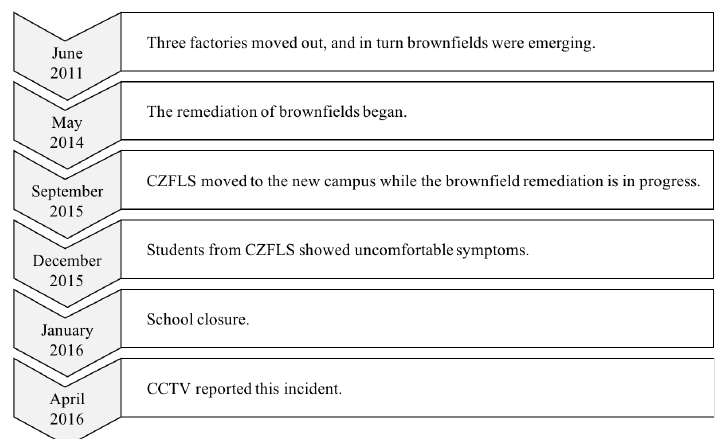
Figure 7. The course of the incident. CCTV, China Central Television.